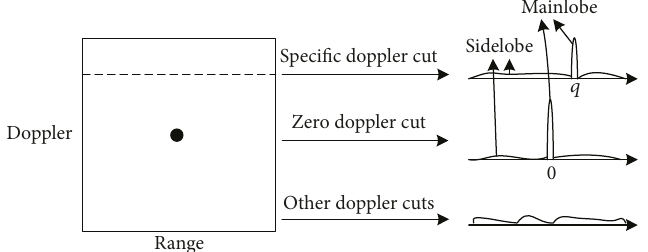
Figure 1: Shape constraints of various Doppler cuts in the ambiguity fi